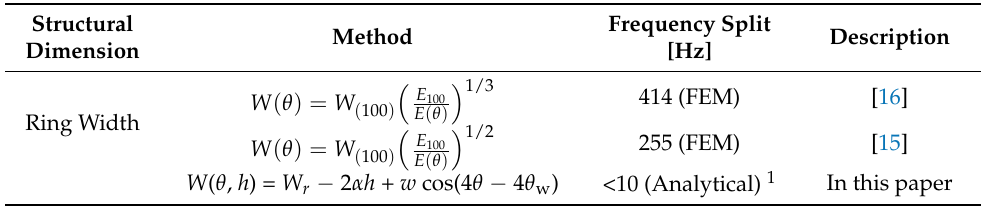
Table 4. Geometrical compensation of ring-based